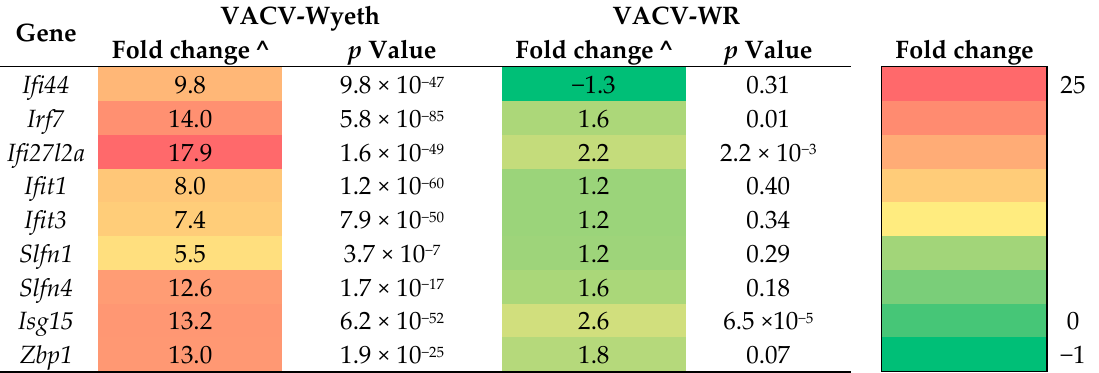
Figure 5. Quantification of up- and down-regulated genes following i.c. infection. Mice were infected with VACV-Wyeth and VACV-WR and total RNA-seq was done from brains 2, 4, and 5 d.p.i. Van diagrams representing number of genes that were significantly up- or down-regulated compared to the carrier control ( p < 0.05, Fold change >2.0). Table 2. Gene expression profile of induced innate immunity 2 days following VACV-Wyeth infection of the CNS.